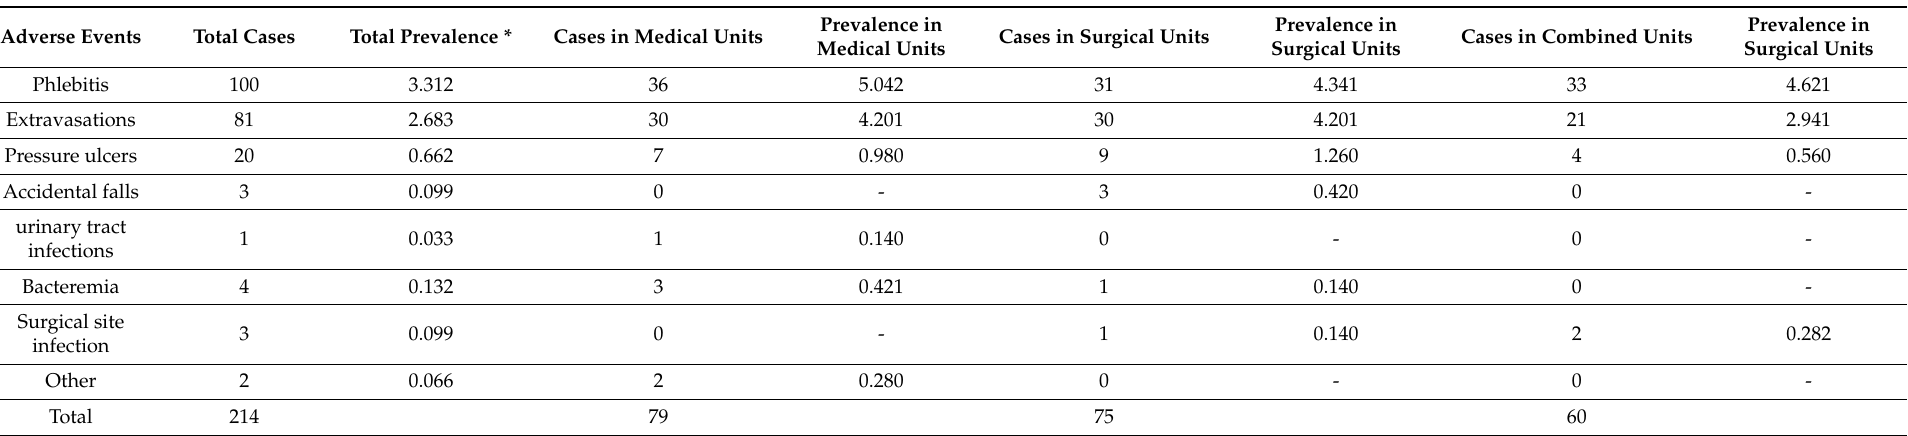
Table 4. Adverse events